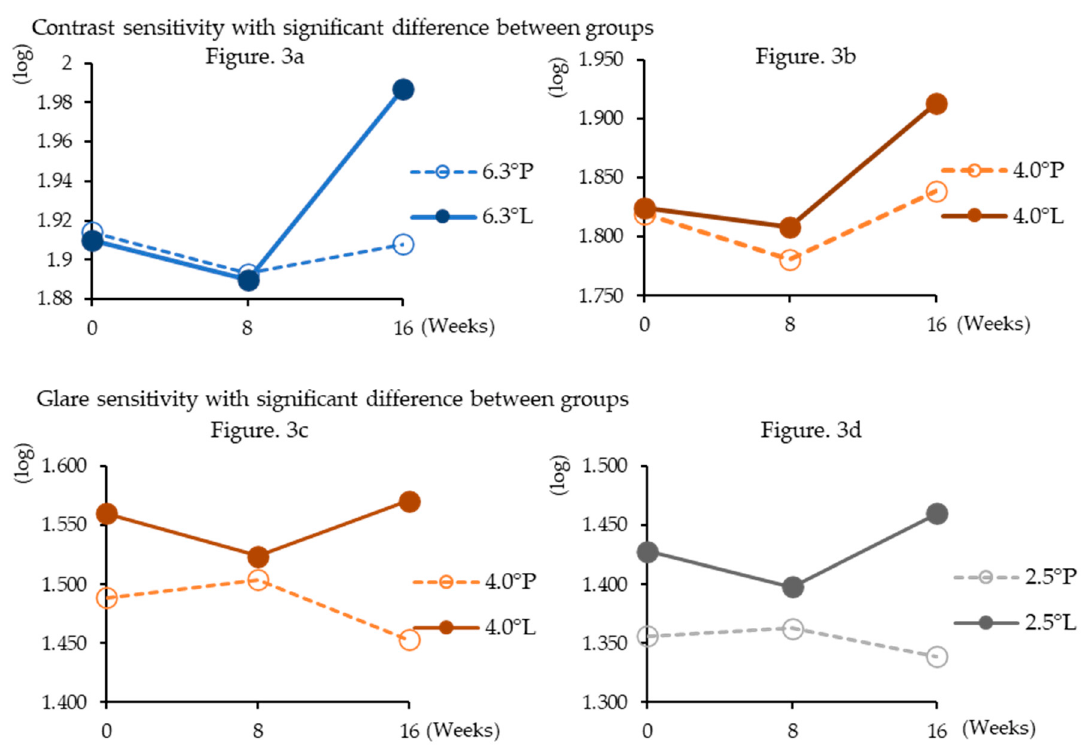
Figure 3. Changes in contrast and glare sensitivities during supplementation. Shows only significantly higher results in the lutein group than in the placebo group. The definition of the legend consists of target sizes and dosing groups (P; placebo group, L; lutein group).